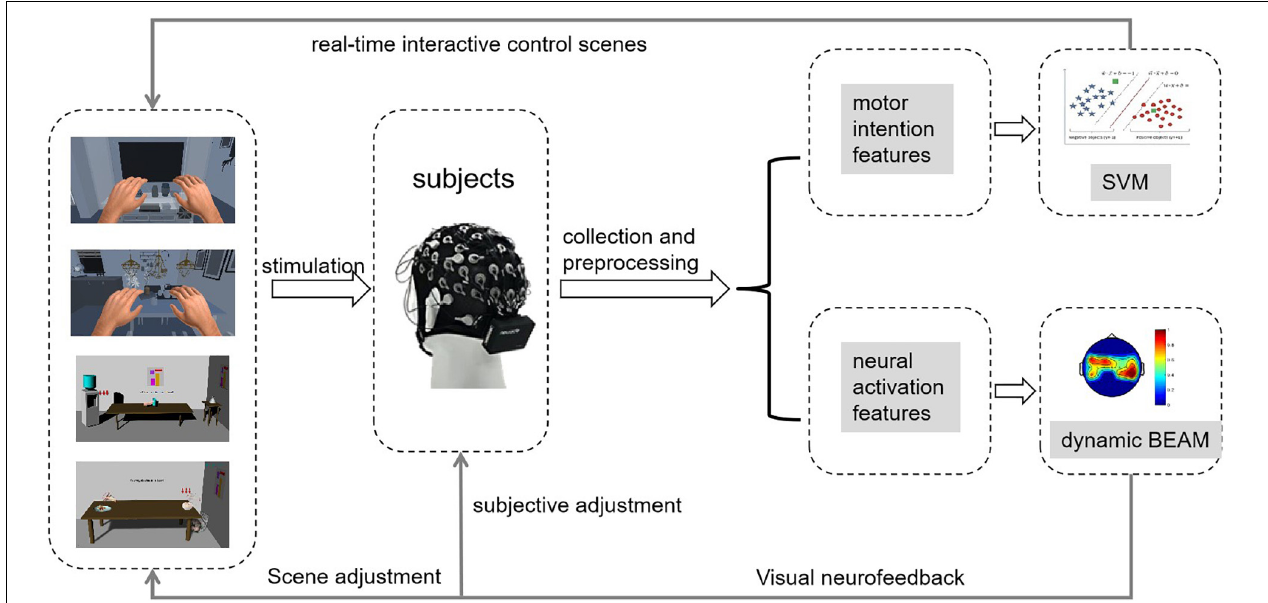
FIGURE 1 | Virtual rehabilitation training strategy